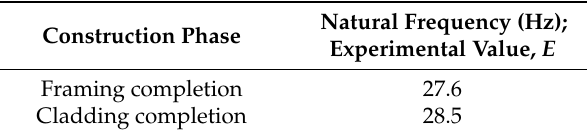
Table 3. Natural frequency.